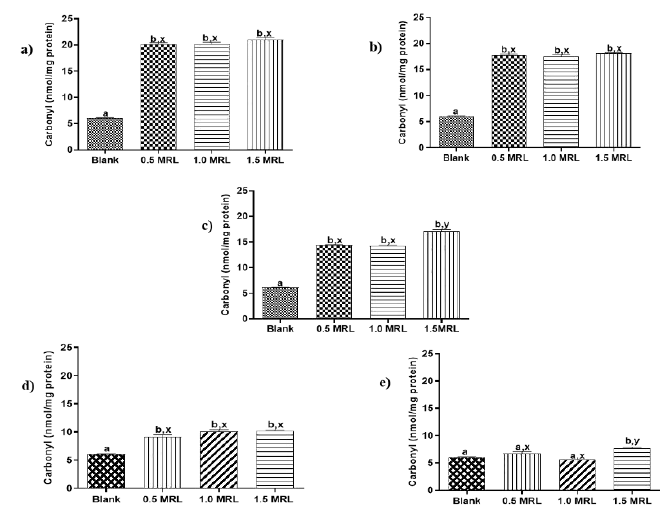
Figure 2. Changes in carbonyl content of sarcoplasmic proteins induced by ( a ) enrofloxacin (ENRO), ( b ) danofloxacin (DANO), ( c ) sarafloxacin (SARA), ( d ) ciprofloxacin (CIPRO) and ( e ) norfloxacin (NOR). Mean values ± standard error of the mean (SEM). Superscripts a-b and x-y show significant statistical differences between means of groups ( p < 0.05): a – b show differences with respect to blank, while x-y differences between FQ concentrations.